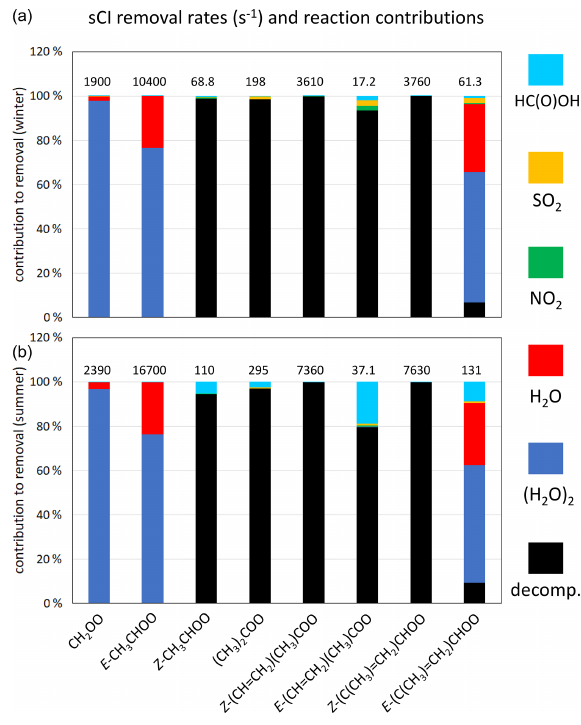
Figure 5. Contributions of the unimolecular and bimolecular re- moval routes for the core set of C 1 –C 4 sCIs under winter condi- tions (a) and summer conditions (b) for representative rural back- ground conditions in the south-eastern UK. The data label shows the total removal rate (in s − 1 ) for the given sCI. Results for an ex- tended series of sCIs, and for suburban and urban traffic conditions, are presented in Supplement